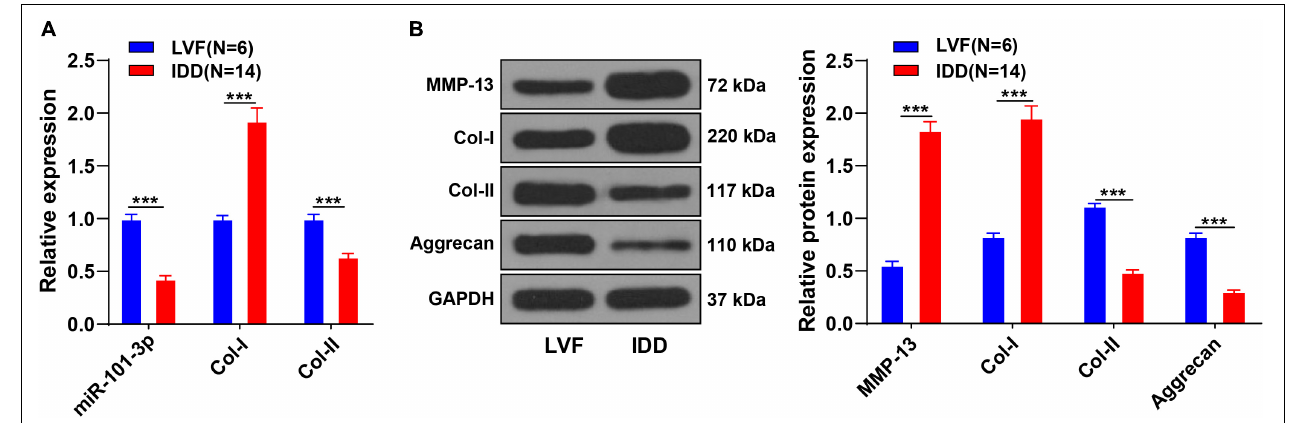
FIGURE 1 | Extracellular matrix (ECM) degradation of nucleus pulposus cells (NPCs) in patients with intervertebral disk degeneration (IDD). NPCs were isolated from the intervertebral disk tissues of patients with IDD, with that of patients with LVF as control. (A) miR-101-3p, Collagen-I (Col-I), and Collagen-II (Col-II) expressions